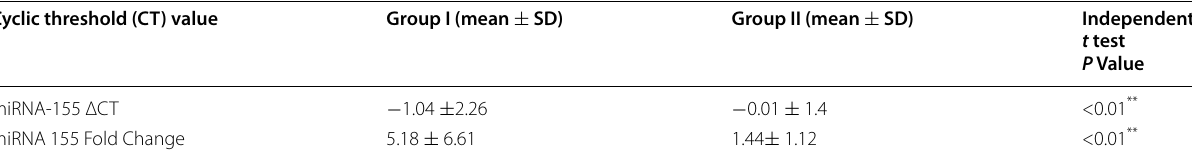
Table 3 The mean standardized ΔCT and fold change values of miRNA-155 expression in groups I and